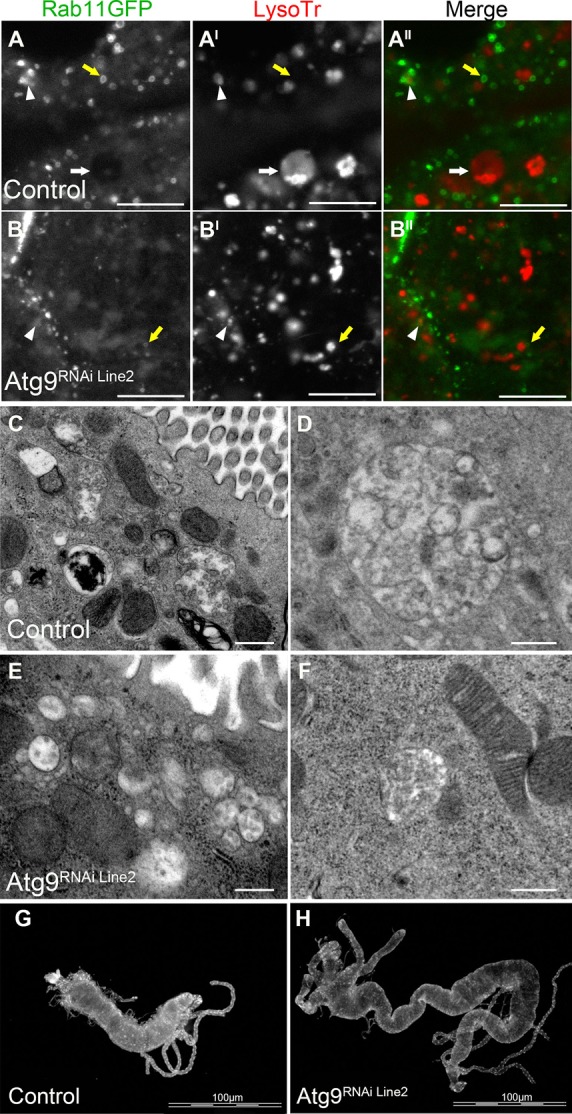
Atg9 depletion reduced the size of Rab11 and LysoTracker compartments and prevented intraluminal vesicles in the gastric caeca, resulting in reduced gut degradation. (A-BII) Confocal micrograph of Drosophila midgut cells at 0 h PF labelled with Rab11-GFP (greyscale in A,B; green in AII,BII), and LysoTracker® (greyscale in AI,BI; red in AII,BII). Arrow heads indicate Rab11-GFP in close proximity to LysoTracker® (A,B), white arrows indicate enlarged LysoTracker® compartments (A), yellow arrows depicted Rab11-GFP as large rings (A,B). Scale bar: 10 μm. (C-F) TEM micrograph of Drosophila midgut cells at 0 h APF, illustrating subcellular compartments containing intraluminal vesicles. Scale bar: 500 nm. (G,H) Fluorescence image of Hoechst stained midguts from +4 h PF pupae. Scale bar: 100 μm. Representative images from heterozygous NP1-GAL4, control (A,C,D,G) and NP1-GAL4>UAS-Atg9RNAi Line2 (B,E,F,H).